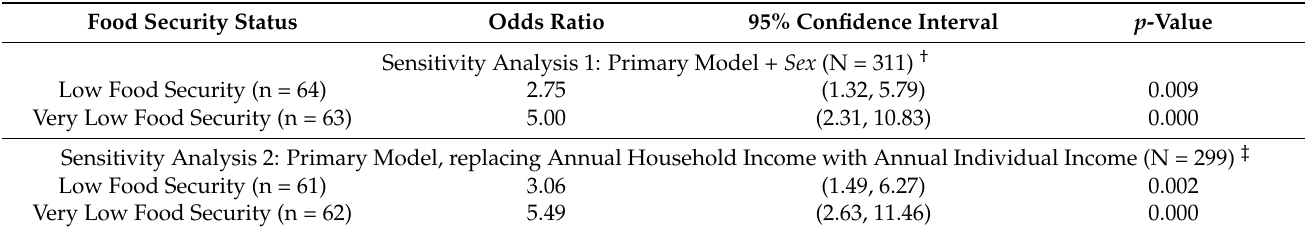
Table 3. Sensitivity analyses with logistic regression estimates (odds ratio) for the association between food insecurity and depression among a cohort of 313 early care and education (ECE) providers in Washington and Texas *.